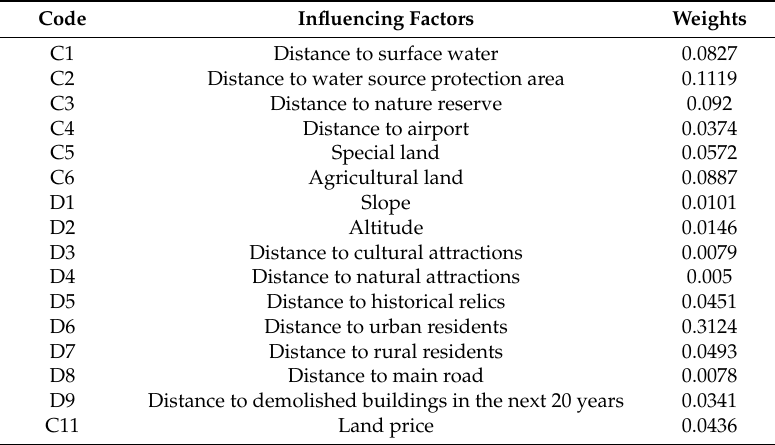
Table 4. Overall weights of the influencing